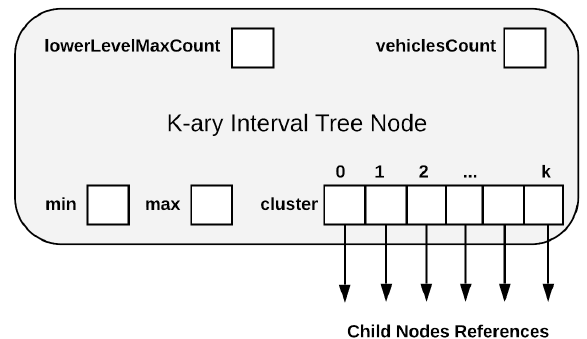
Figure 4. KI Tree Node Structure.